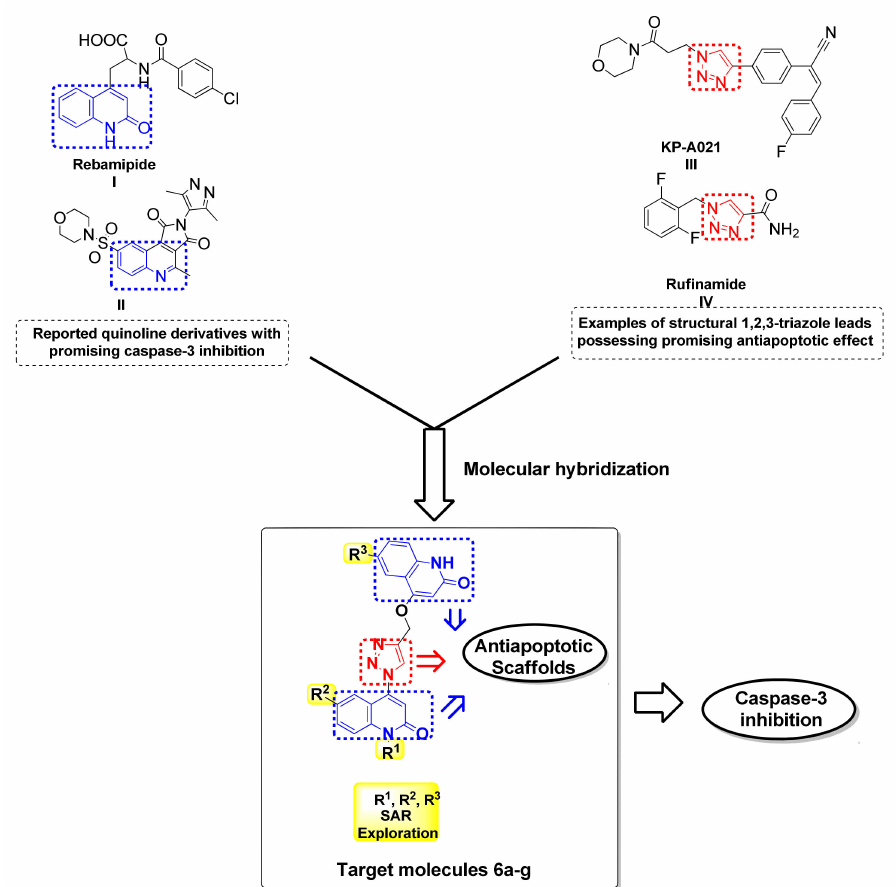
Figure 1. Examples of reported quinoline and 1,2,3-triazole based antiapoptotic drugs and caspase-3 and the design strategy for the target hybrids 6a – g